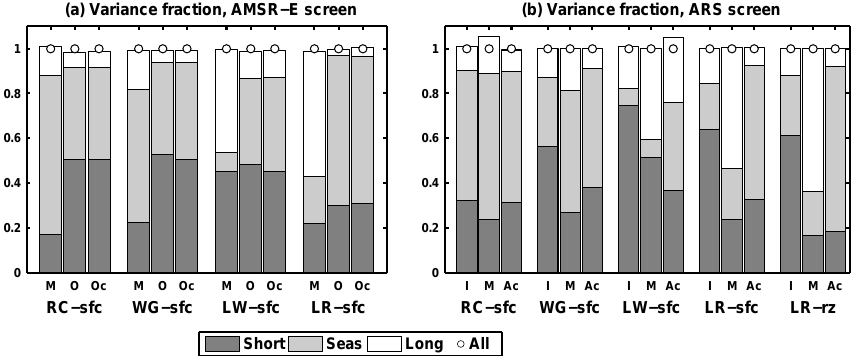
Figure 4. Fraction of variance at each timescale, obtained by normalizing the time series variance before decomposition. The Catchment model (M), original AMSR-E observed (O), and the CDF-matched AMSR-E-observed (Oc) soil moisture time series, cross-screened for AMSR-E availability, are plotted in (a) , and the ARS in situ observations (I), Catchment model (M), and baseline assimilation (Ac) soil moisture time series, cross-screened for ARS availability, are plotted in (b) . The circles give the variance of the original (normalized) soil moisture time